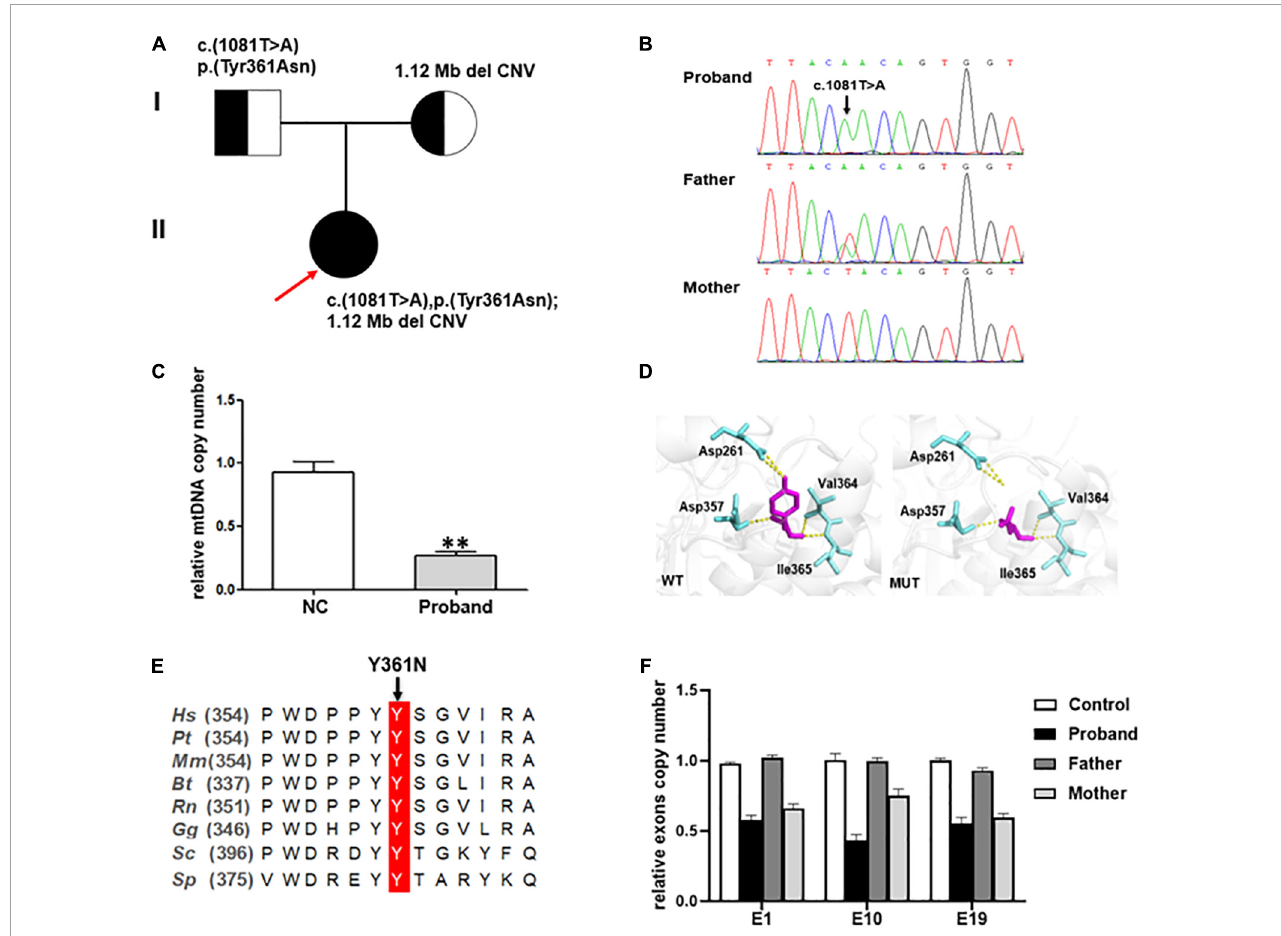
FIGURE2 (A) Pedigree of the family reported in the present study. The arrow depicts the proband. The circles correspond to the women. The squares indicate the men. (B) Direct sequencing showing the novel missense variant c.1081T > A of the MIPEP gene. (C) The mtDNA copy numbers in healthy controls ( n = 3) and the proband. A notable reduction in the mtDNA level was noted in the proband (NC, normal control, ∗∗ P < 0.01). (D) Structural visualization of the identified MIPEP missense alteration using Alpha Fold structure of the human MIPEP as a template (Identifier:AF-Q99797-F1). The variant site and the relevant residues were shown as sticks (the variant site is shown in magenta and the relevant residues are shown in aquamarine). The yellow dotted line represents the H-bond that connects the variant site with the residues. (E) Alignment of MIPEP orthologs in different species around the mutated amino acids residues. Hs , Homo sapiens ; Pt , Pan troglodytes; Mm , Macaca mulatta; Bt , Bos taurus; Rn , Rattus norvegicus; Gg , Gallus gallus; Sc , Saccharomyces cerevisiae S288C; Sp , Schizosaccharomyces pombe. (F) MIPEP gene exons RT-qPCR analysis showed a heterozygous loss of exons 1, 10, and 19 in the proband and his